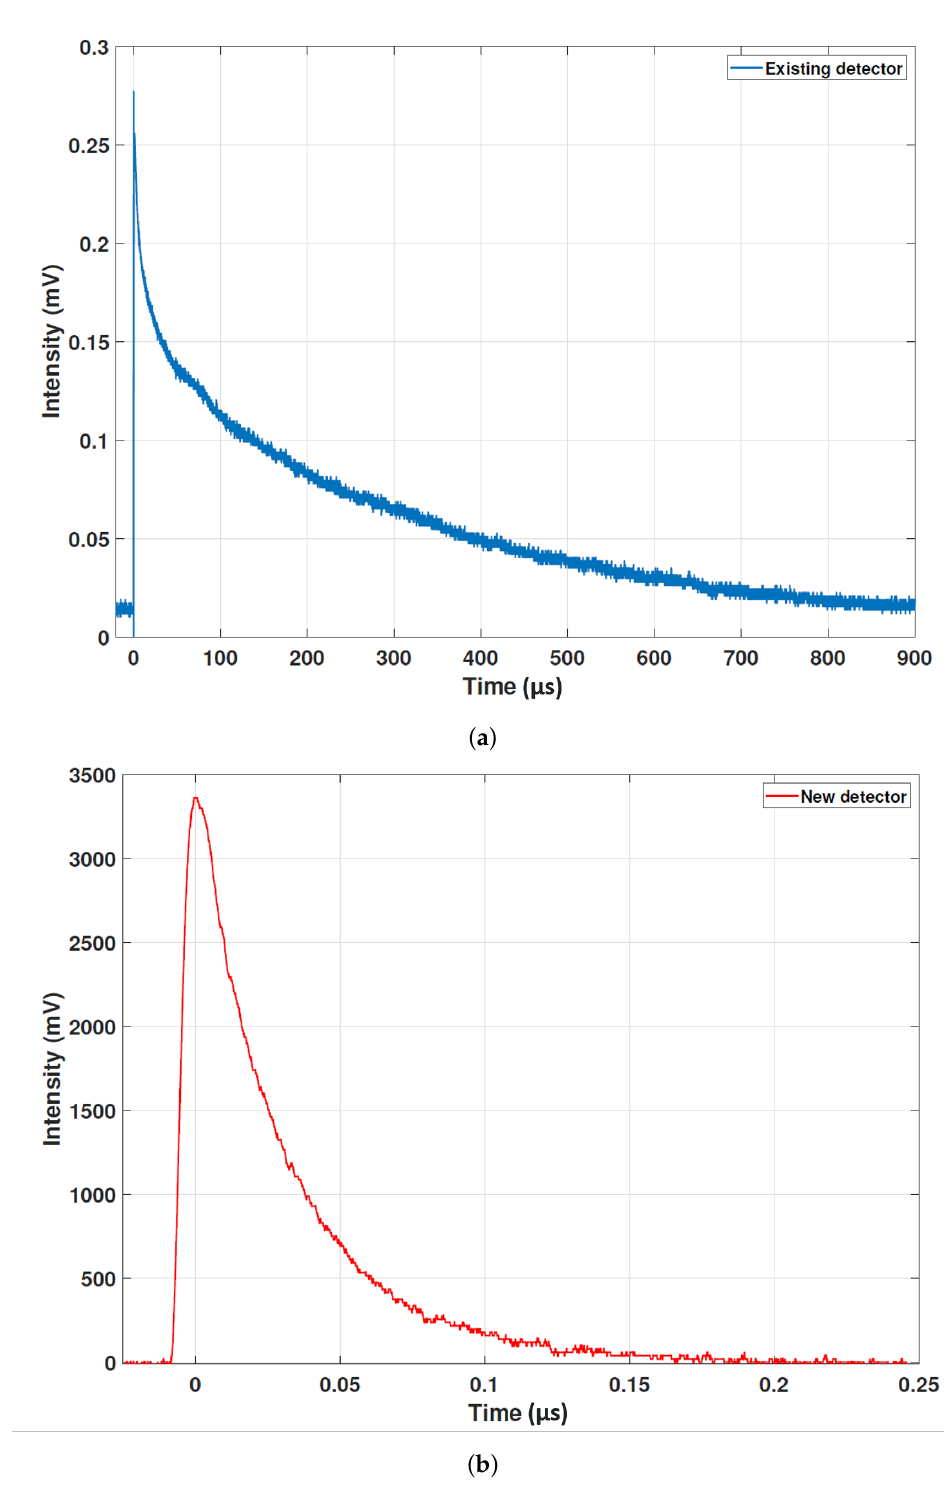
Figure 14. The response to a 5 ns laser pulse in the existing system ( a ) and the new system ( b